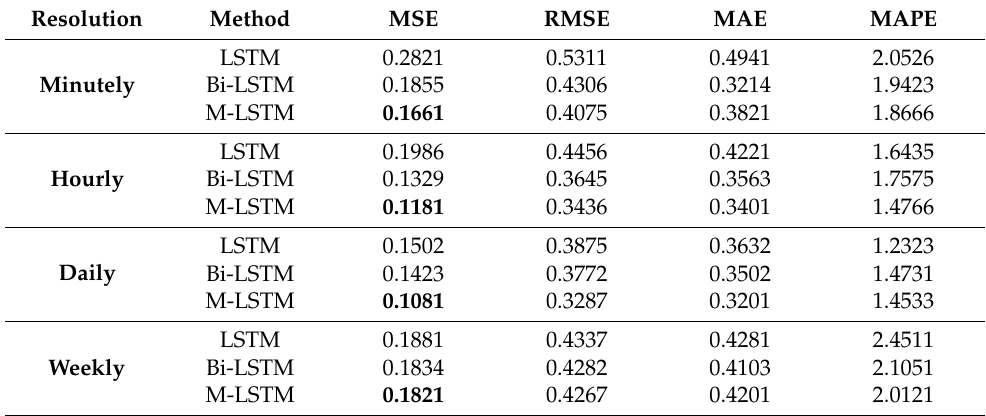
Table 10. Results obtained for the sequential learning algorithm on different horizons using 10-fold method where the bold values represent the best achieved